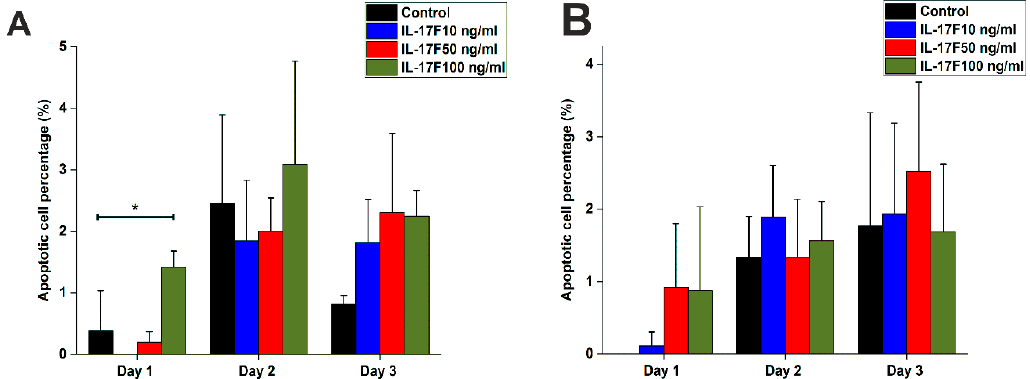
Figure 3. Effects of IL-17F on apoptosis levels in OTSCC cells. ( A ) In Day 1, 100 ng/mL of IL-17F increased apoptosis levels in the highly invasive HSC-3 cell line compared with the non-stimulated controls. A similar trend was also observed in the following days, but the differences were not statistically significant. ( B ) In Day 1, IL-17F (at 50 and 100 ng/mL) seems to slightly increase apoptosis signals in the less-invasive SCC-25 cell line, however, the response was generally less consistent and not statistically significant. In Days 2 and 3, this effect was not found. * p ≤ 0.05.